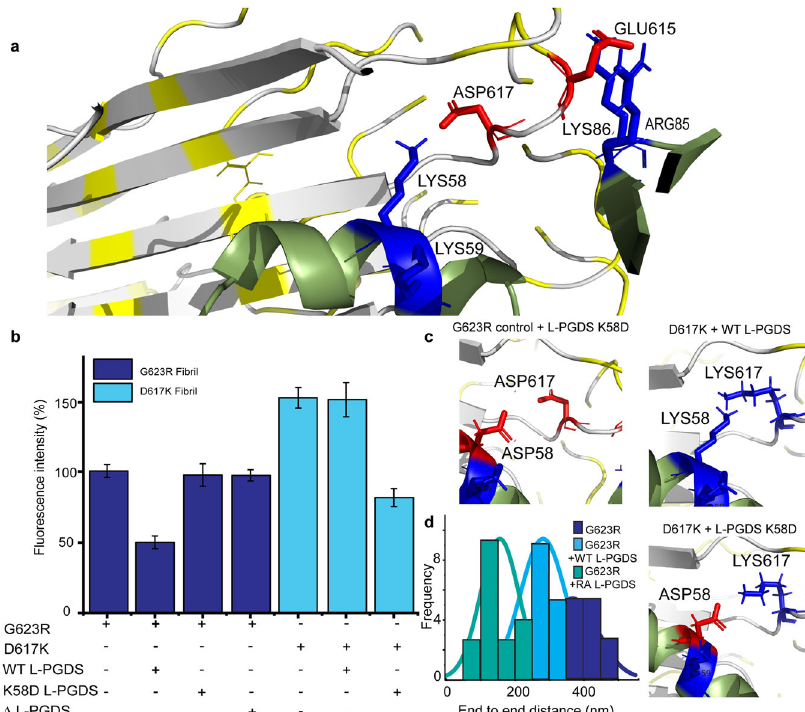
Fig. 4 Interaction interface between L-PGDS and the G623R fi bril. a Zoomed-in image of the docking model displaying electrostatic interaction between E615, D617 of G623R fi bril and K58, K59 & R85, K86 of L-PGDS, respectively. b End point ThT assay showing the ThT fl uorescence intensity of the G623R and D619K fi bril, its complex with L-PGDS, mutant K58D of L-PGDS, and mutant K58A, K58A of L-PGDS ( Δ L-PGDS) n ≥ 3 independent experiments. c Zoomed-in 3D representations of the interactions between G623R with mutant K58D of L-PGDS, mutant D617K of G623R with L-PGDS, mutant D617K of G623R with mutant K58D of L-PGDS. The negatively charged ASP residue is colored in red and the positively charged LYS residue is colored in blue. d Histogram showing the end-to-end distance of G623R fi bril incubated with PBS buffer only, L-PGDS and double mutant (K58R, C65A) of L-PGDS (RA L-PGDS).